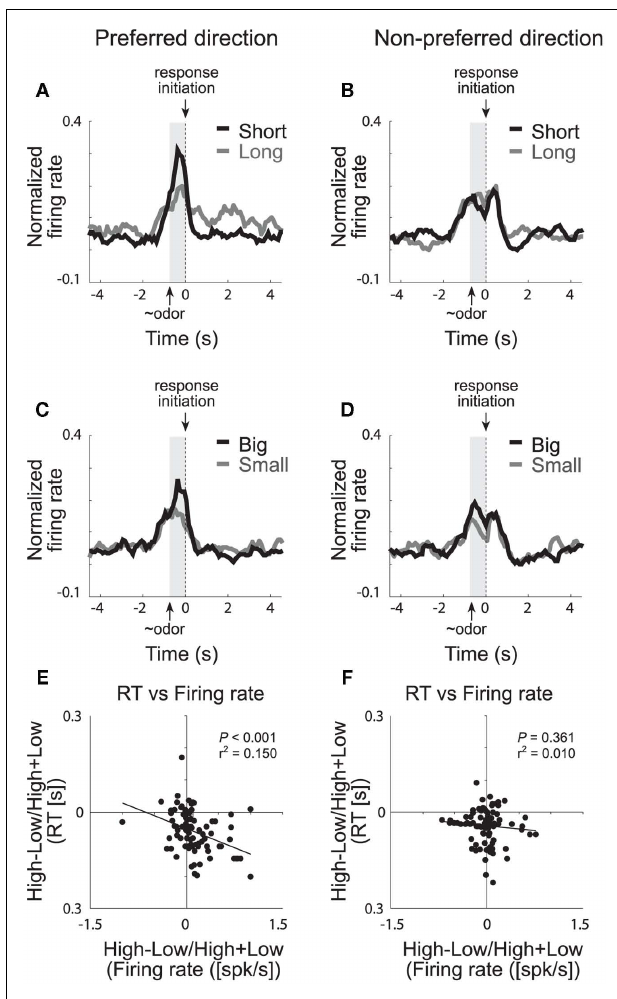
FIGURE 5 |Ventral striatum (VS). Population activity of odor-responsive neurons reflected motivational value and response direction on forced-choice trials. (A–D) Curves representing normalized population firing rate during performance of forced-choice trials for the odor-responsive neurons as a function of time under the eight task conditions (high value = black; low value = gray). Data are aligned on odor port exit. Preferred and non-preferred directions are represented in left and right columns, respectively. For each neuron, the direction that yielded the maximal response was designated as preferred. Correlations in the preferred (E) and non-preferred (F) direction between value indices (short − long/short + long and big − small/big + small) computed for firing rate (during odor sampling) and reaction time (speed at which rats exited the odor port after sampling the odor; adapted from Roesch et al.,